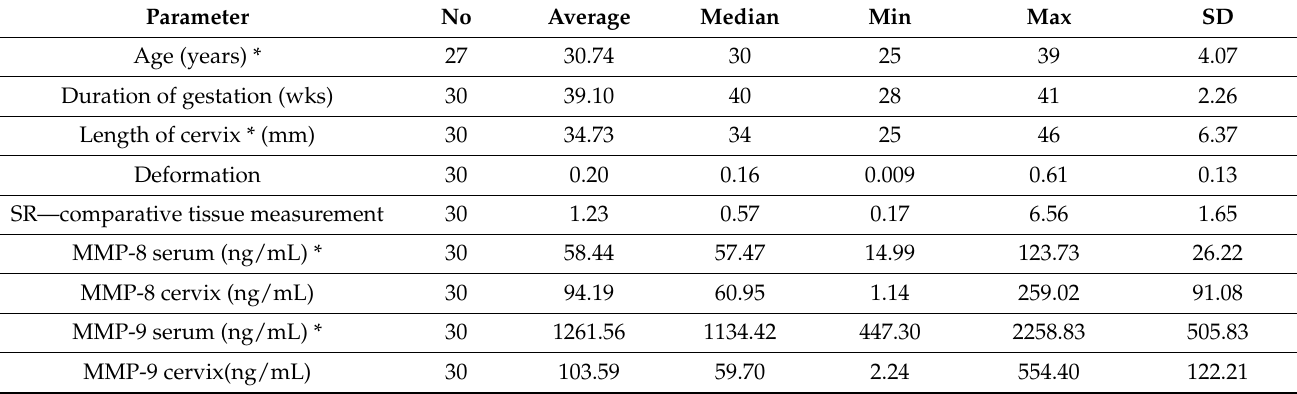
Table 3. Detailed characteristics of the control group in terms of selected demographic and clinical parameters. Parameter